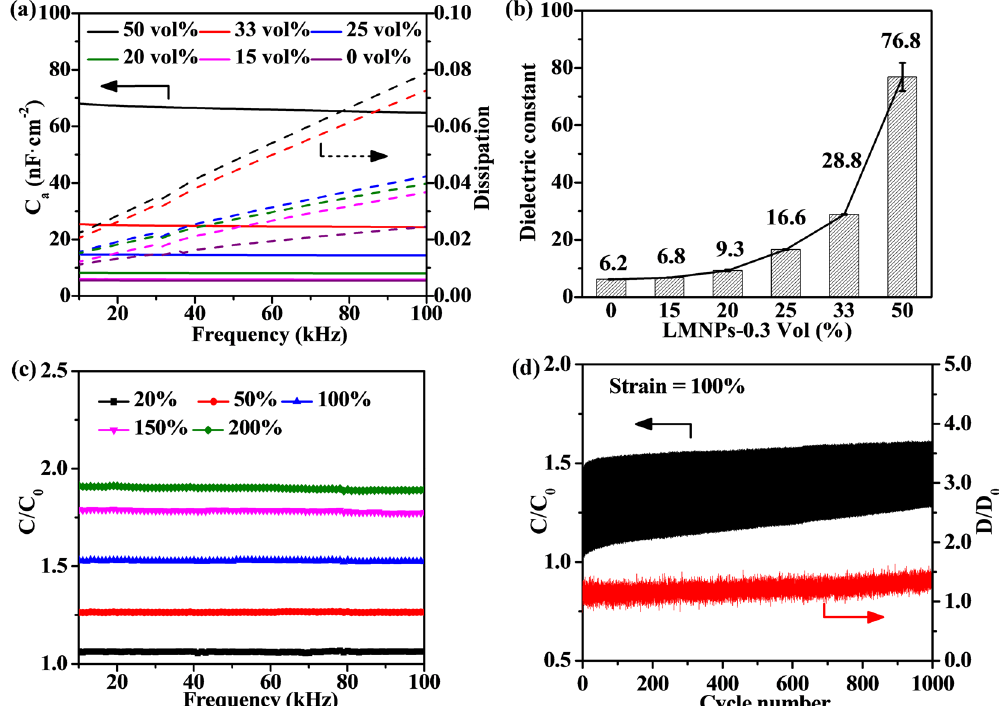
Fig. 4 Electrical performance of LM-based stretchable dielectrics. a Comparison of speci fi c capacitance and dissipation of LMNPs-0.3/55PU with various LMNPs-0.3 volume percentage under 10 – 100 kHz. b Dielectric constant of LMNPs-0.3/55PU with various LMNPs-0.3 volume percentage under 100 kHz. The error bars show the standard deviation. c Normalized capacitance of 50%LMNPs-0.3/55PU subjection to various strain under 10 – 100 kHz. d Normalized capacitance and dissipation of 50%LMNPs-0.3/55PU subjection to 100% strain for 1,000